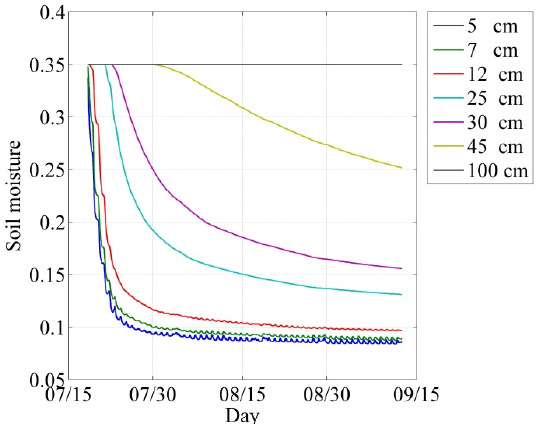
Figure 11. Soil moisture content profile obtained by hydrodynamic simulation.